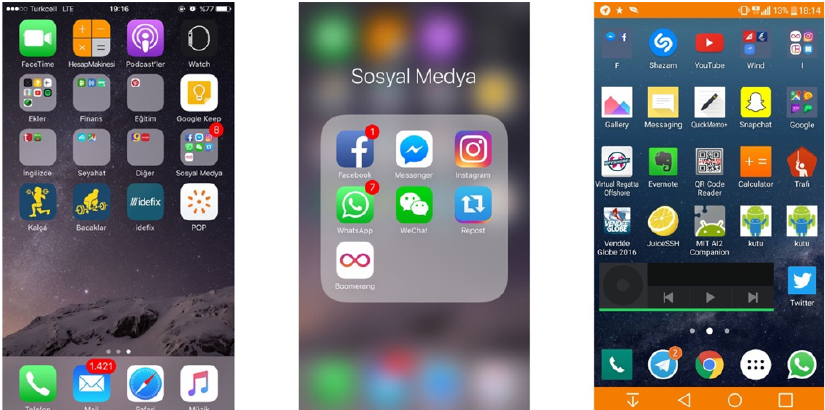
Figure 5: Sample screenshots from participants’ home